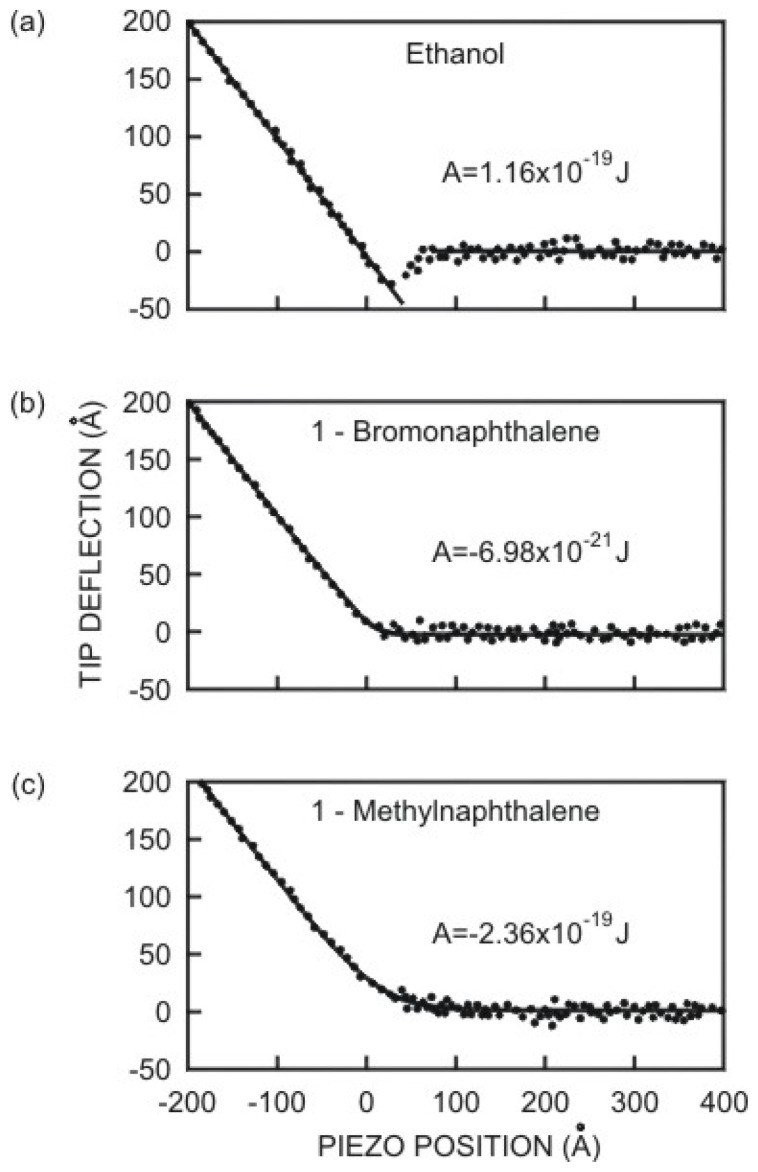
Representative deflection vs. piezo extension curves for a Si3N4 tip interacting with a mica sample across various media. In each case, the Hamaker constant was calculated from the fitting parameter: (a) Attractive interaction in ethanol (β = 44.9 Å); (b) small repulsive interaction in 1-bromonaphthalene (β = −22.2 Å); and (c) repulsive interaction in 1-methylnaphthalene (β = −56.9 Å) (Reproduced by permission of American Institute of Physics [114]).